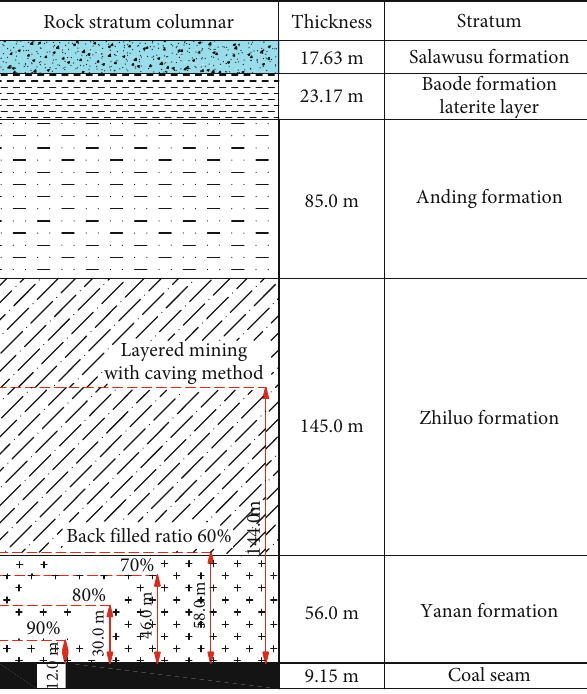
Figure 8: Simulation results of the water-conducting fracture height under di ff erent mining